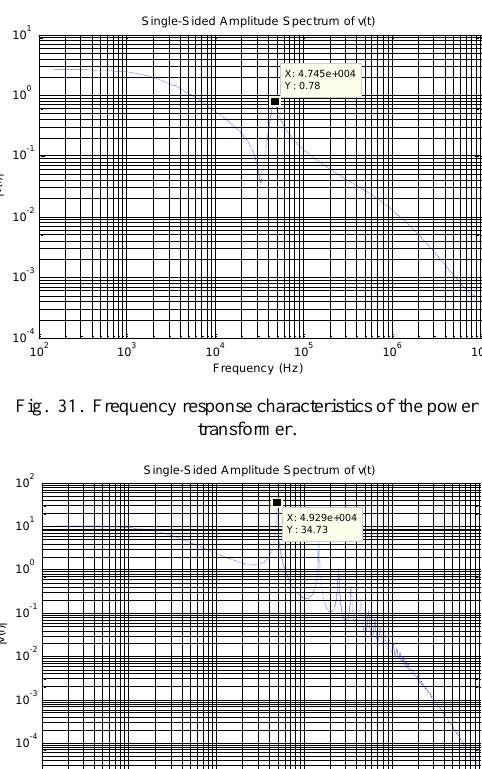
Fig. 30. Lightning impulse voltage waveform.